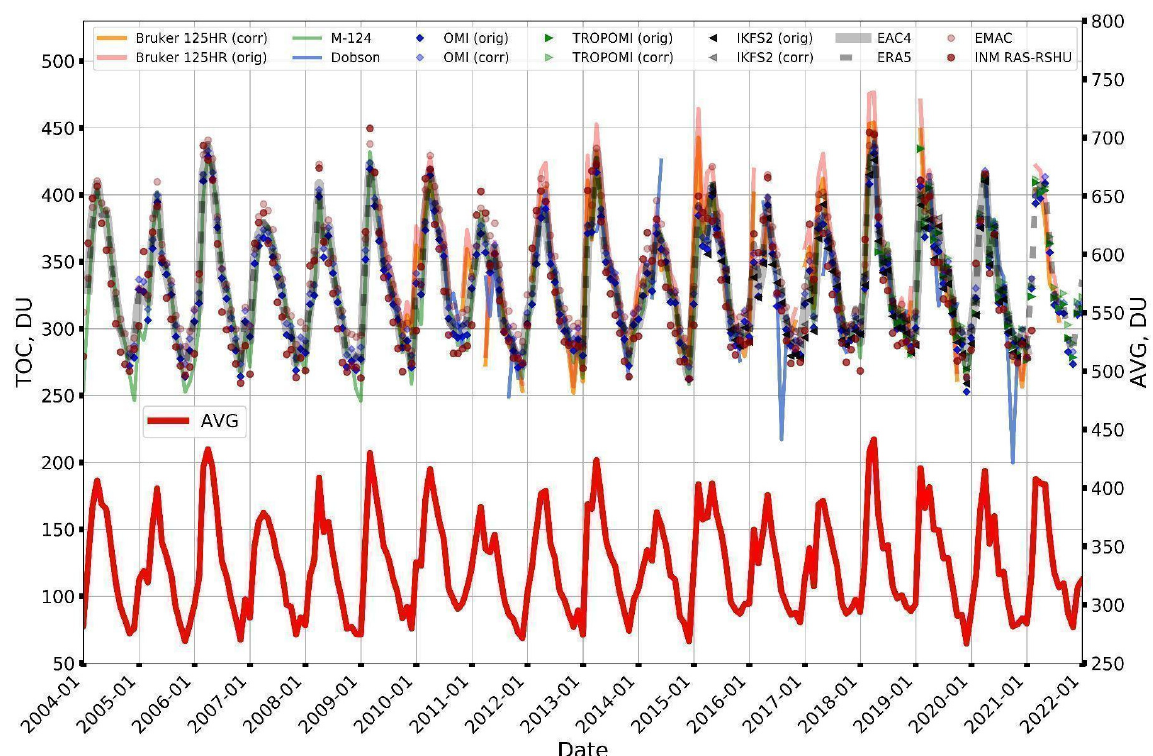
Figure 9. Time series of monthly averaged TOC near St. Petersburg in the 2004–2021 period according to the observation and simulated data.